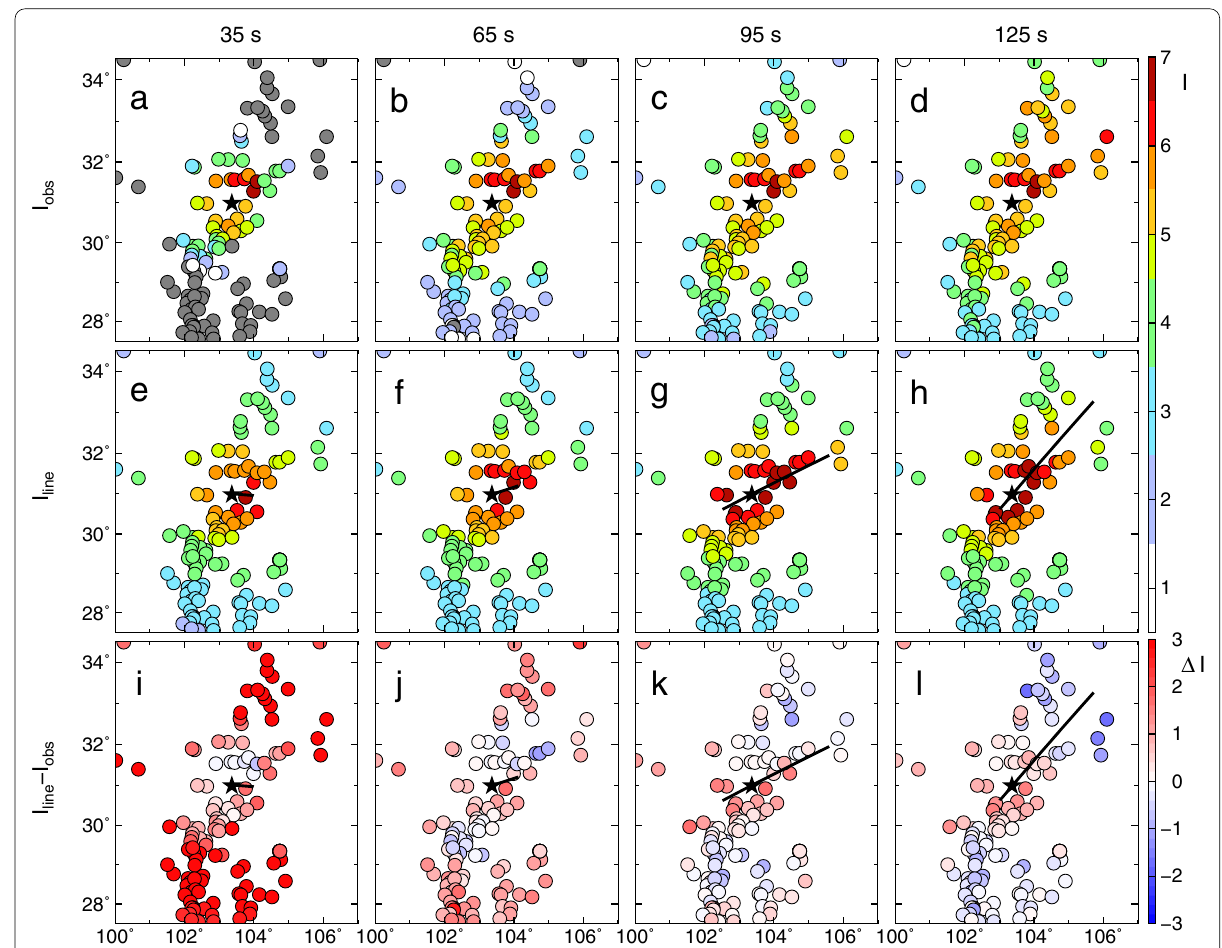
Fig. 11 Snapshots of the seismic intensities of the LS model for the 2008 Wenchuan earthquake. The format is the same as in Fig.